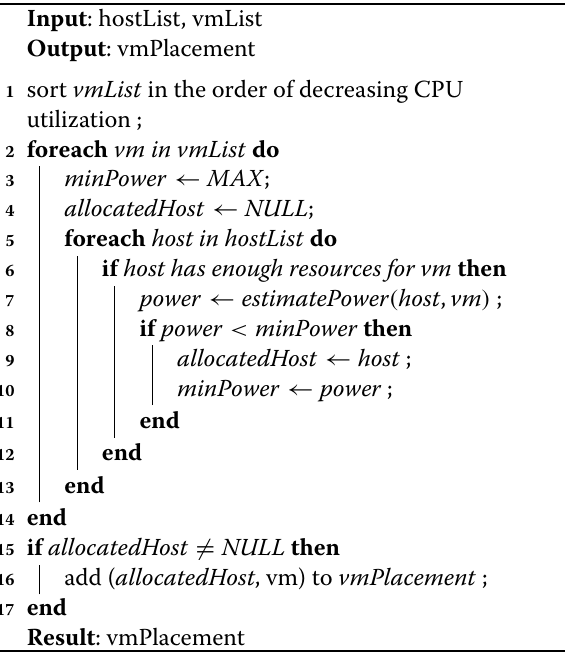
Algorithm 4: The Modified Best-Fit Decreasing Algorithm 5: The Power Aware Best-Fit Decreasing